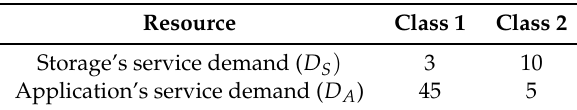
Table 2. Service demands of two considered